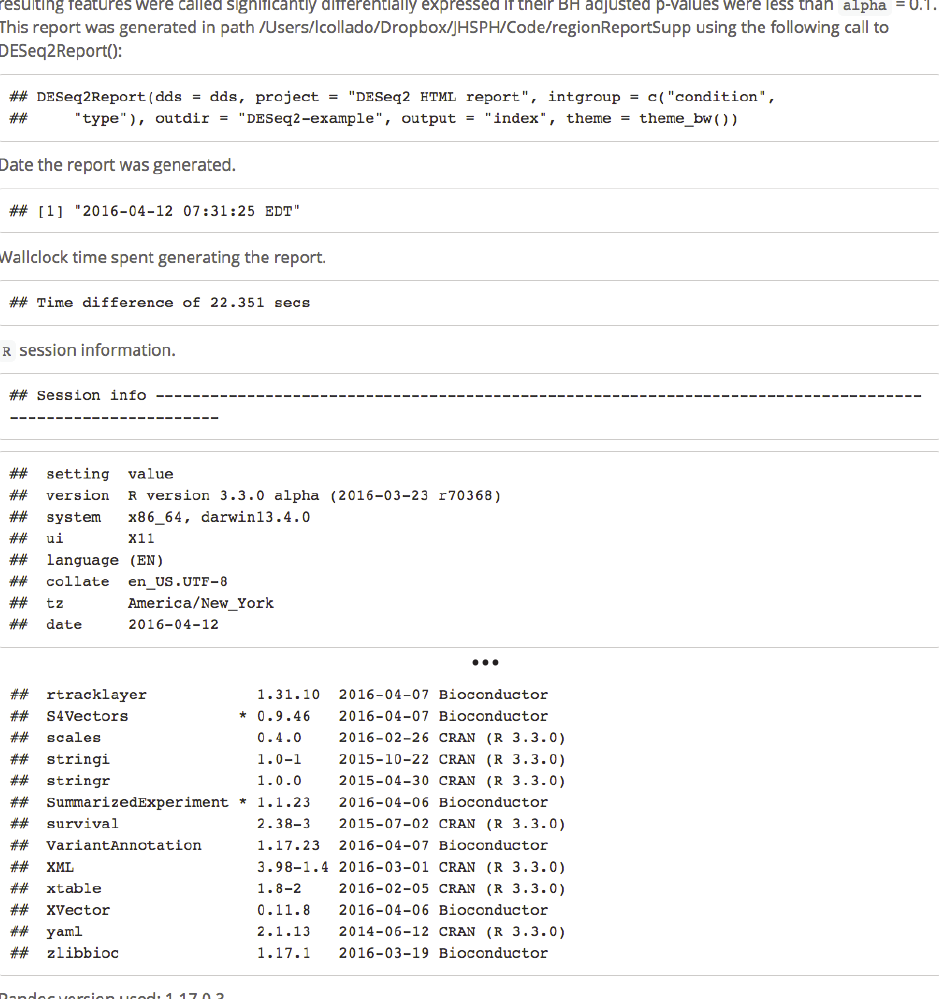
Figure 6. Reproducibility section for a report using DESeq2 results. The reproducibility information includes the actual function call used to generate the report, the path where the report was generated, the time it took to create the report, details about the R session information, and the pandoc version used for rendering the HTML report. For reports based on DESeq2 results, the version used to perform the differential expression analysis and cutoff used are also displayed. Note that DESeq2 version used for the analysis and for the report might differ.